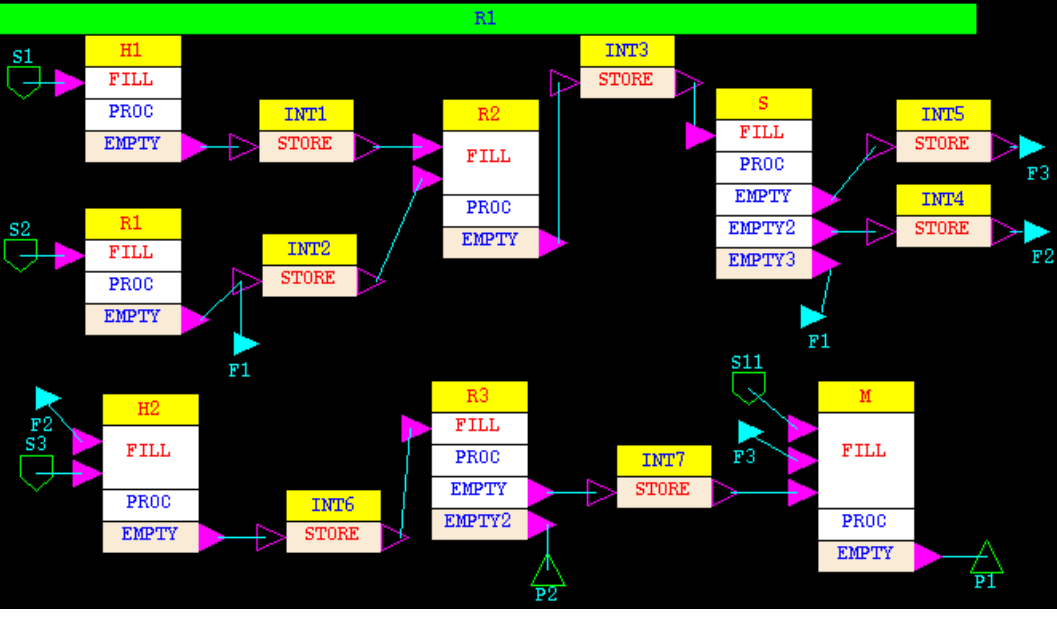
Figure 12. Recipe network for Example 5. Table 5. Key process parameters for Example 5.